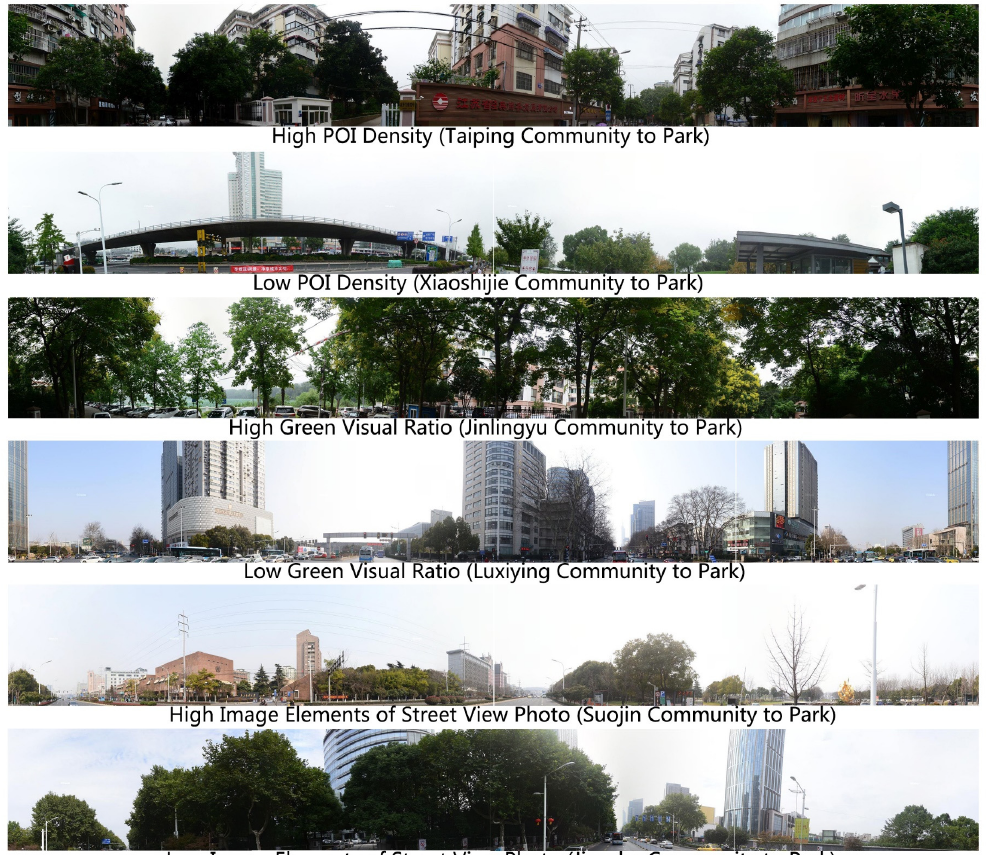
Figure 8. Street view photos of pedestrian environments.